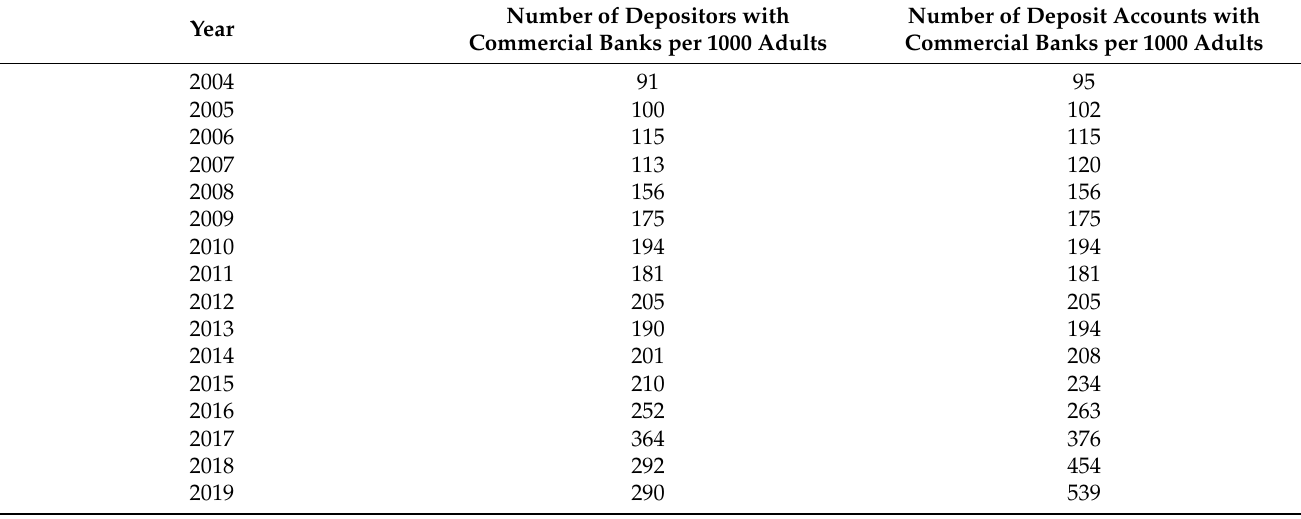
Table 3. Trends in depositors and deposit accounts with commercial banks per 1000